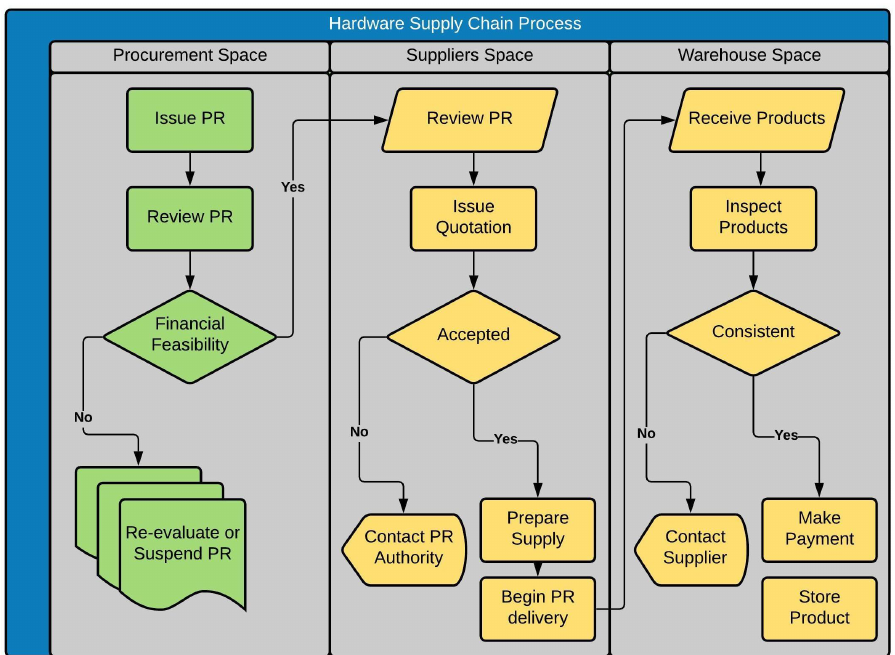
Figure 4. Proposed secure supply chain business